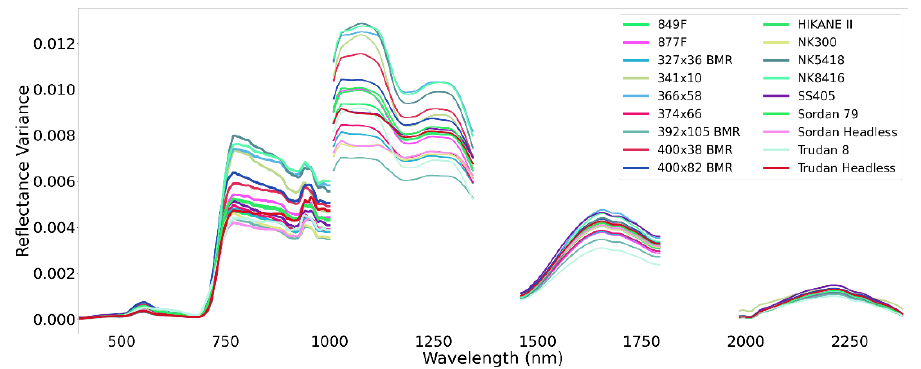
Figure A4. Variance of the spectra of the 18 Sorghum Varieties in HyCal-18 panel on 18 July 2018. The varieties are very similar in the visible range of the spectrum, but substantial variability is observed in the NIR portion of spectrum.